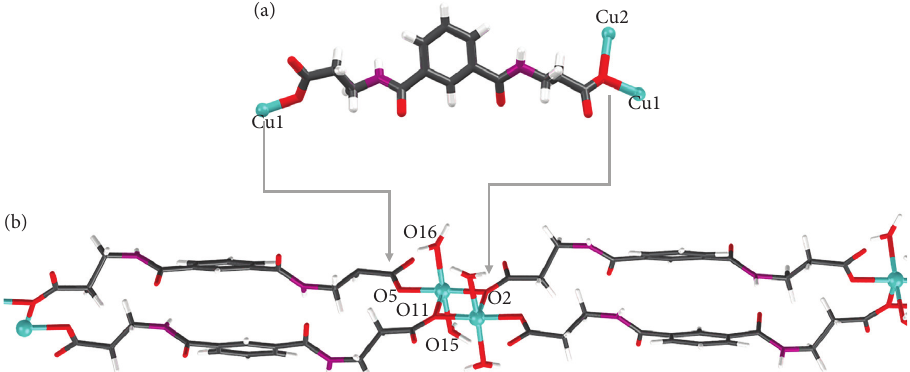
Figure 2: Isophthaloyl bis β -alanine (H 2 IBA) coordination modes to Cu (II) metal centers in compound 1 (a). Structure fragment of compound 1 (b). Color code: Cu � light blue, O � red, N � purple, C � grey, and H �